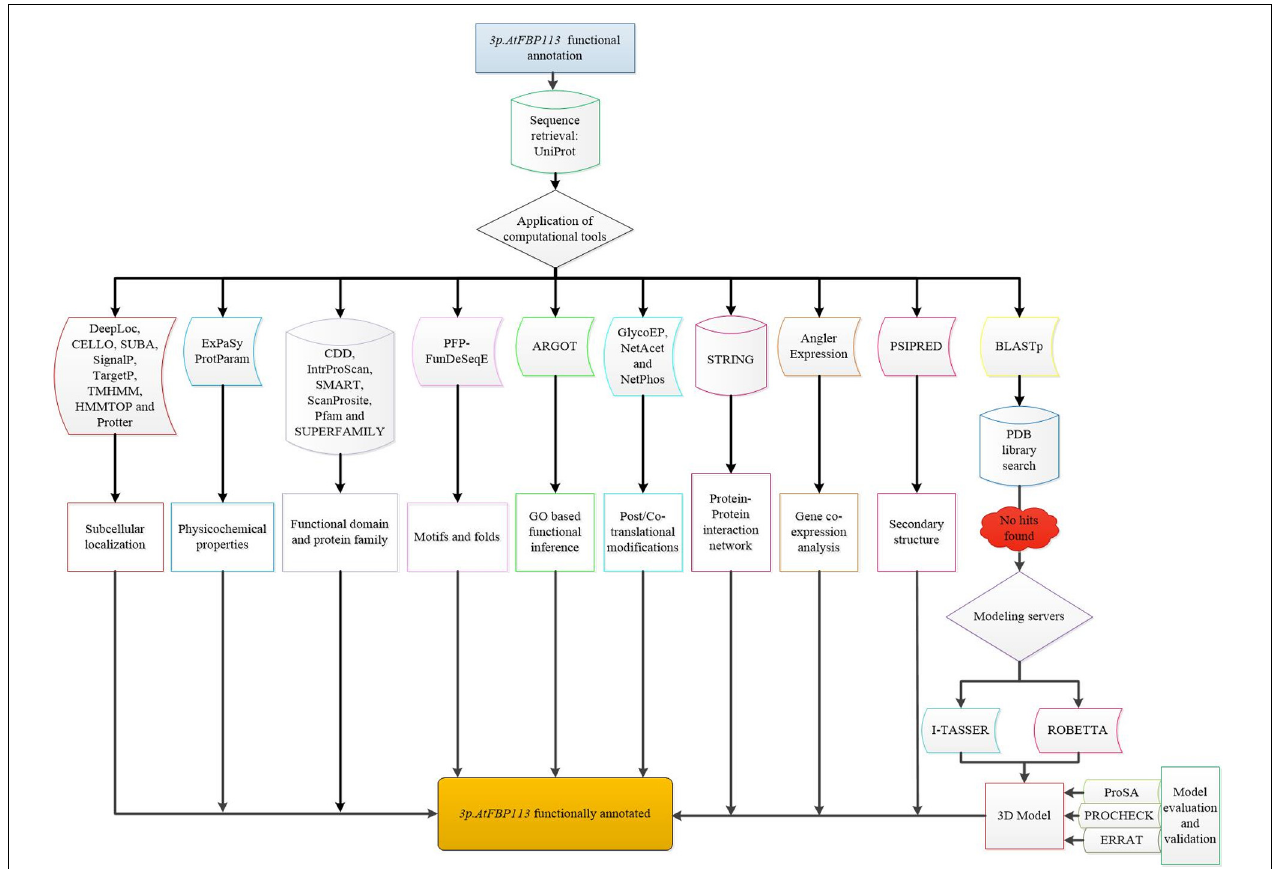
FIGURE 3 | Flowchart demonstrating the functional annotation of 3p.AtFBP113 . The diagrammatical representation depicts the comprehensive step by step methods used for inferring the probable functions of 3p.AtFBP113.